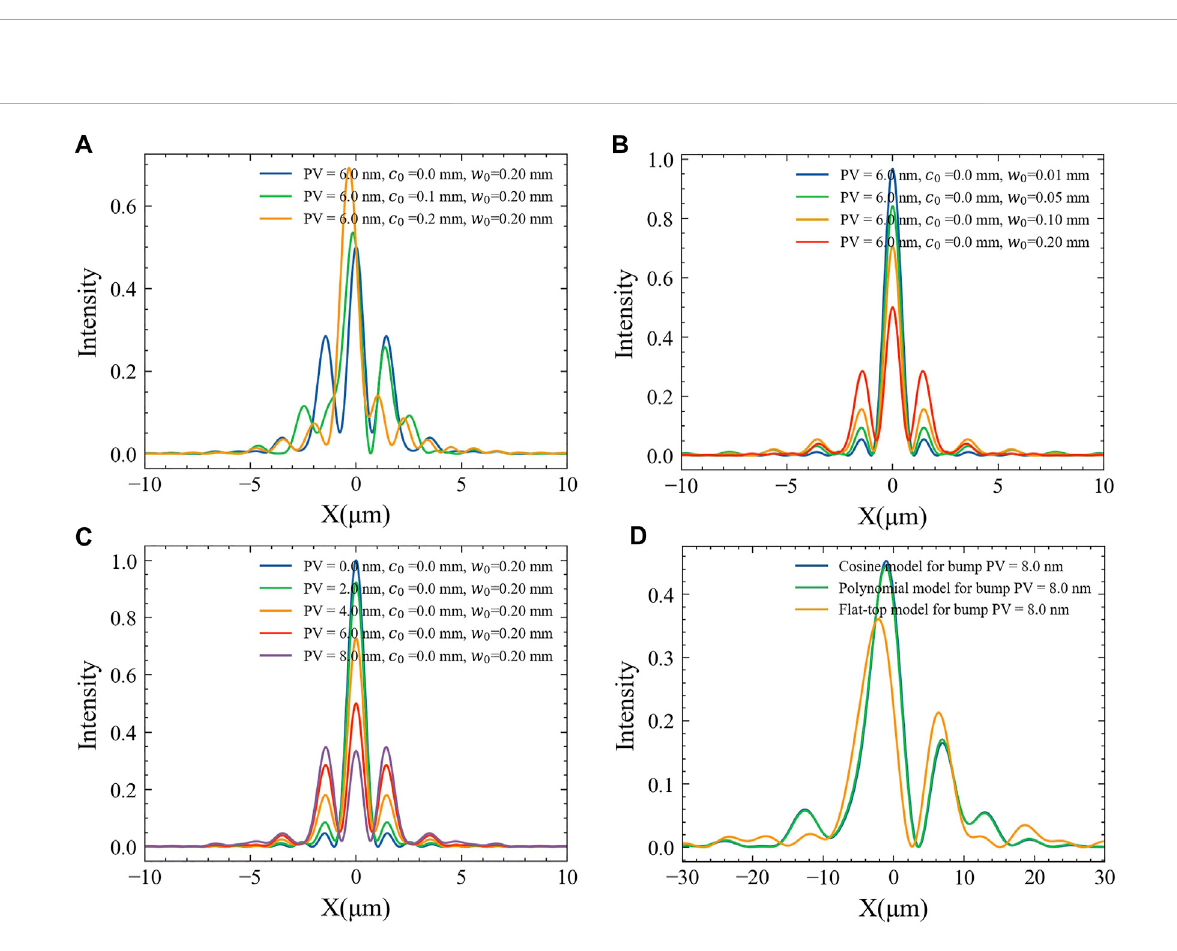
FIGURE 9 Bump model of simulation considering the effect of position (A) , width (B) , height (C) , and shape (D)